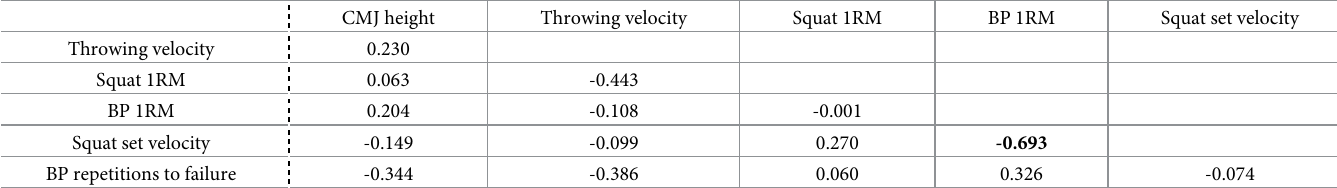
CMJ, countermovement jump; BP, bench press; 1RM, one-repetition maximum. Data are presented as Pearson’s correlation coefficients (r). Bold number indicates a significant correlation (p �